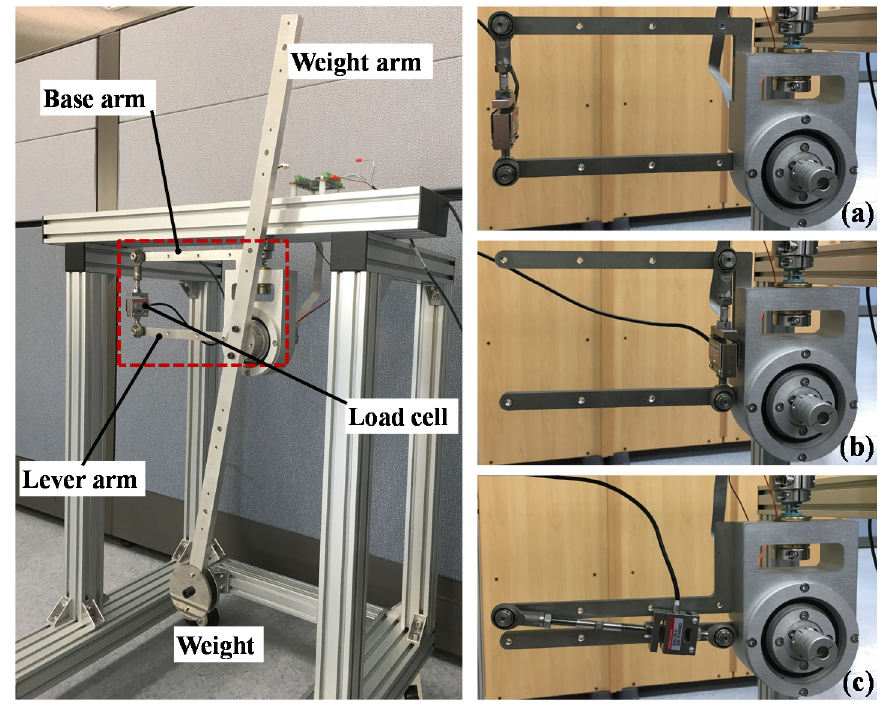
Figure 8. The torque sensor prototype assembled with a weight to apply torque. ( a ) d LC = 200 mm, ( b ) d LC = 50 mm, and ( c ) d LC = 6.608 mm.